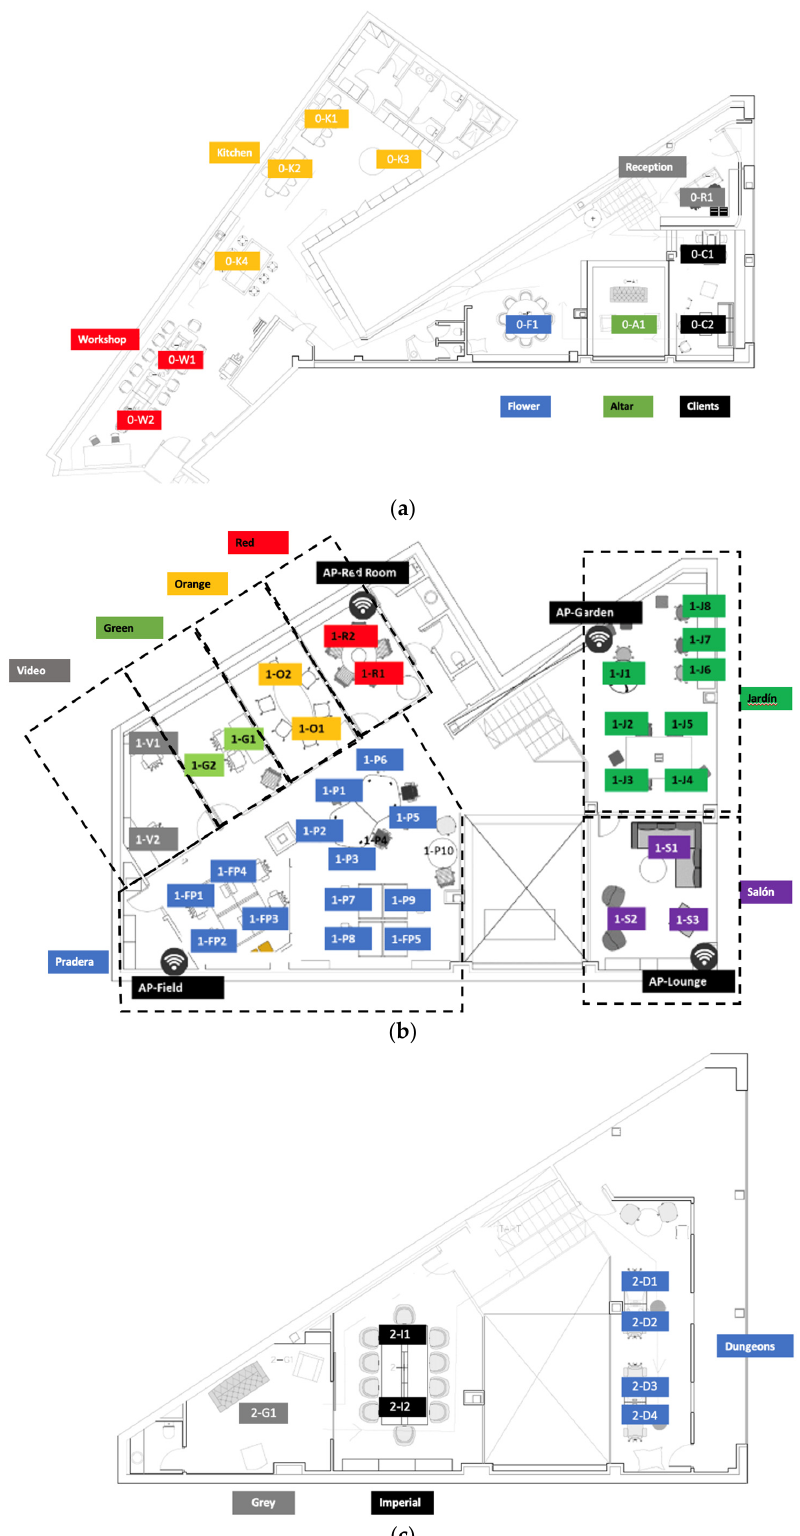
Figure 6. Example of workplace area layout tagged by DARs identified by colors. APs are also tagged and named. ( a ) Ground Floor (spaces: Workshop, Kitchen, Flower, Altar, Clients, and Reception); ( b ) First Floor (spaces: Jard í n, Salon, Pradera, Video, Green, Orange, and Red); ( c ) Second Floor (spaces: Dungeons, Imperial, and